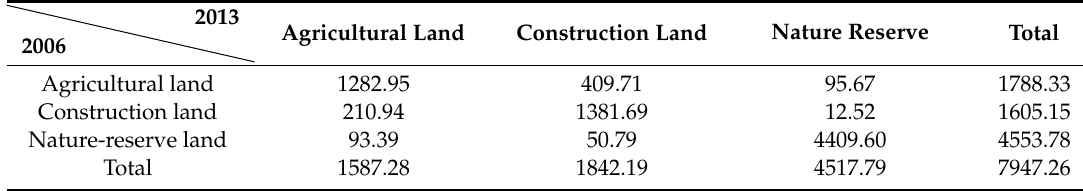
Table 5. The 2006–2013 area transition matrix (unit: km 2 ).